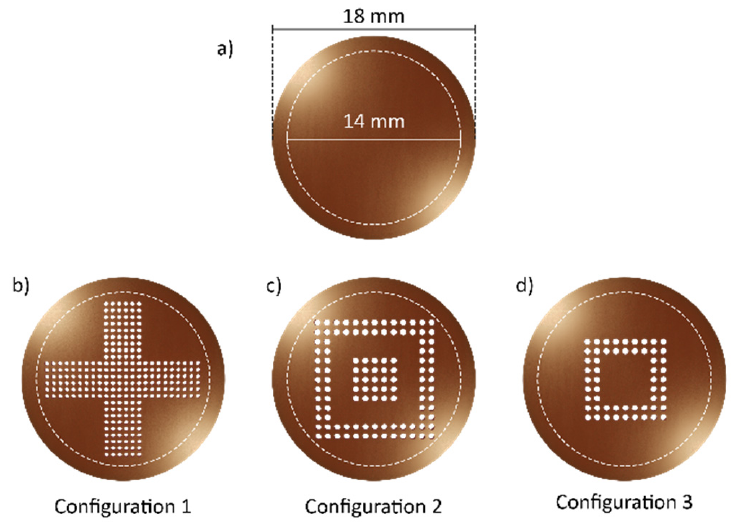
Figure 2. Design of the micromembrane. The main dimensions are indicated in ( a – d ) report on the different pores’ distribution in the three configurations. Pores’ size not to scale.